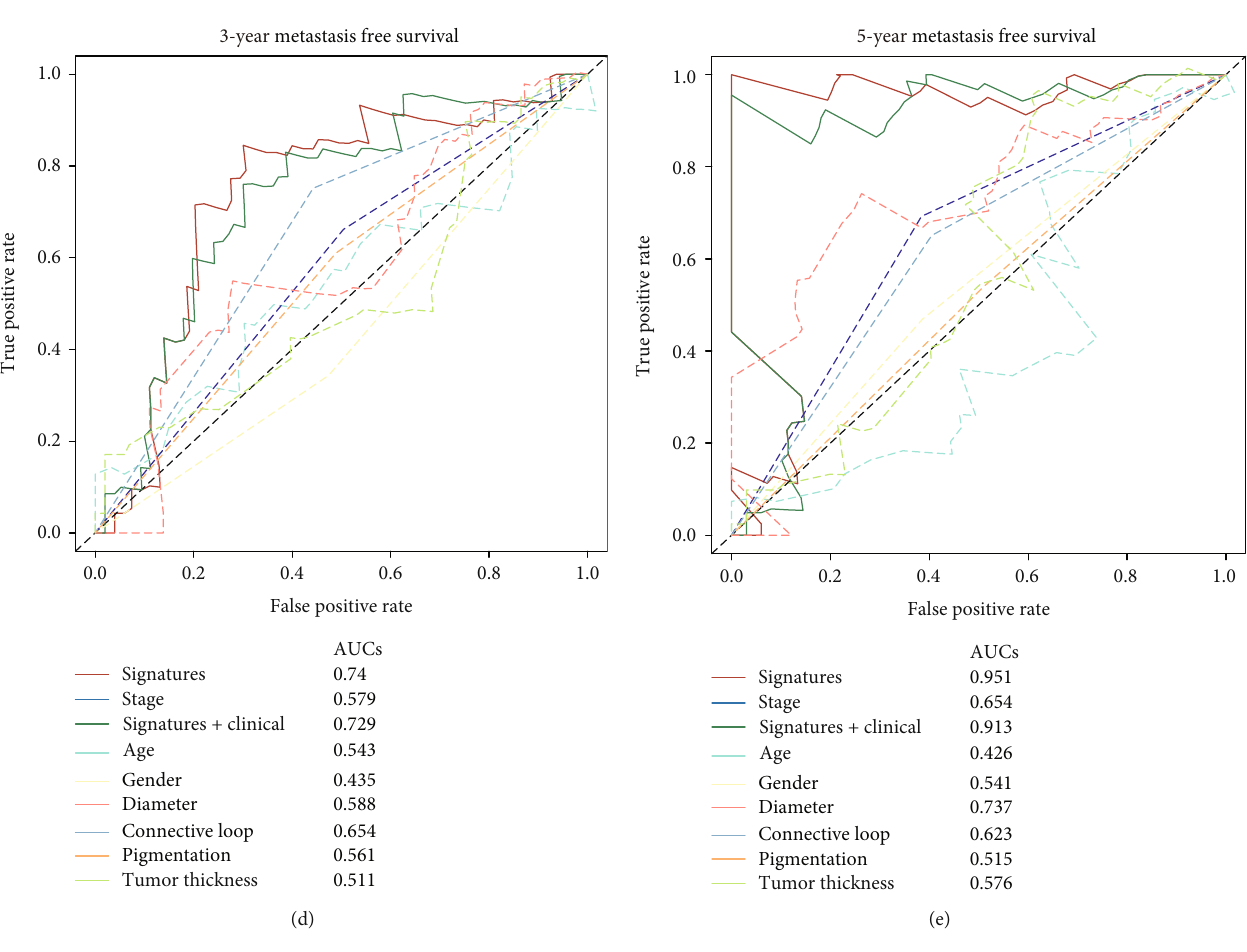
Figure 5: Validation of UMPS in the TCGA cohort. (a) Risk score distribution. (b) Survival overview. (c) Survival curve of UMPS for metastasis-free survival. The high-risk group had worse metastasis-free survival than the low-risk group. (d, e) Time-dependent receiver operating characteristic (ROC) analysis for comparing the performance of UMPS and the clinicopathological factors. The AUC of UMPS was higher than the single clinicopathological factor in predicting 3-y and 5-y metastasis-free survival. The addition of UMPS could improve the performance of the AJCC TNM staging